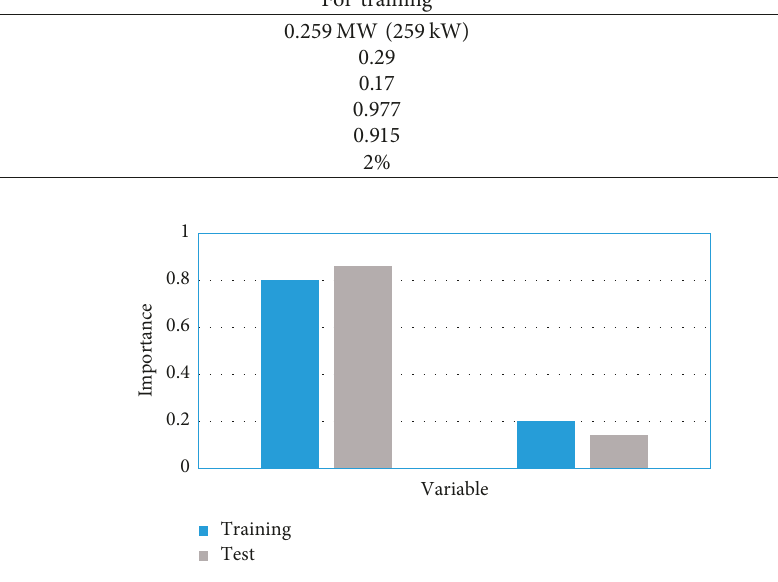
Figure 7: Variable importance.